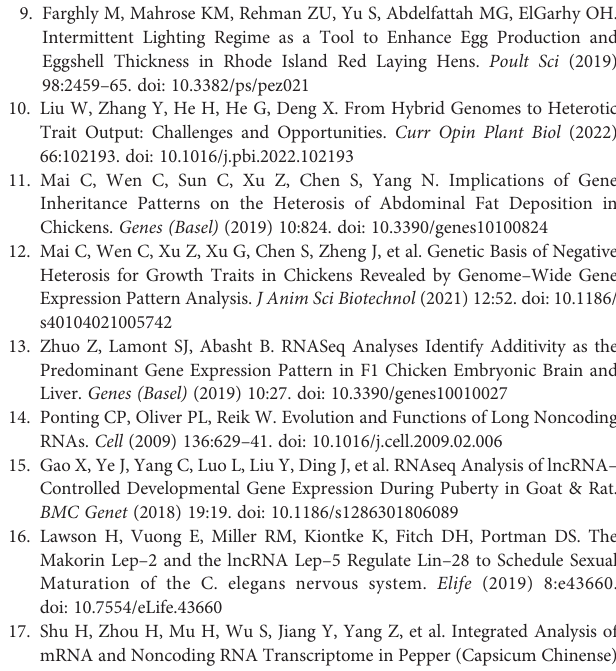
Supplementary Figure 1 | Chromosomal distribution of putative and known lncRNAs. Supplementary Figure 2 | Principal components analysis (PCA) of identi fi ed and genes in the crossbreeds (WY, YW) and purebreds (WW, YY). Supplementary Figure 3 | The Venn analysis of nonadditive lncRNAs and genes inWYandYW.(A)TheVennanalysisofnonadditivelncRNAsinWYandYW.(B)The Venn analysis of nonadditive genes in WY and YW. Supplementary Figure 4 | The expression of FSHR and ESR2 in different groups.